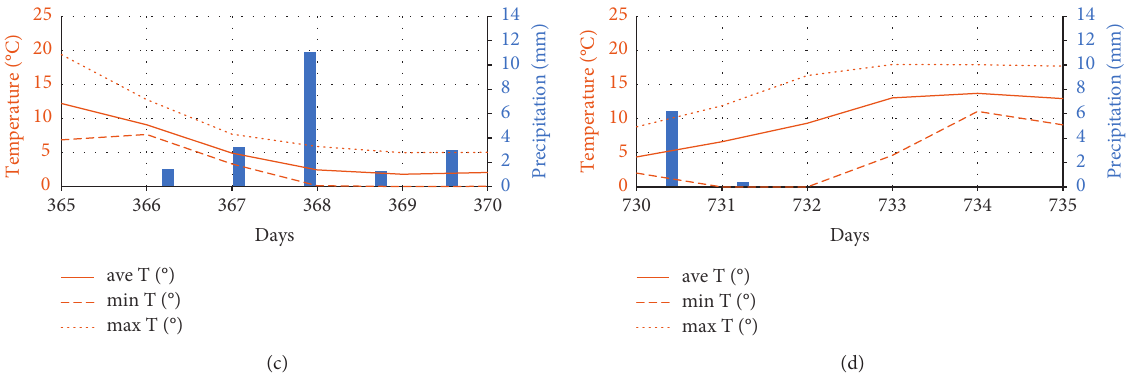
Figure 10: Weather conditions in the field. Day 1–day 50 (a), day 110–day 115 (b), day 365–day 370 (c) [24], and day 730–day 735 (d): average, minimum, and maximum temperature and precipitation.